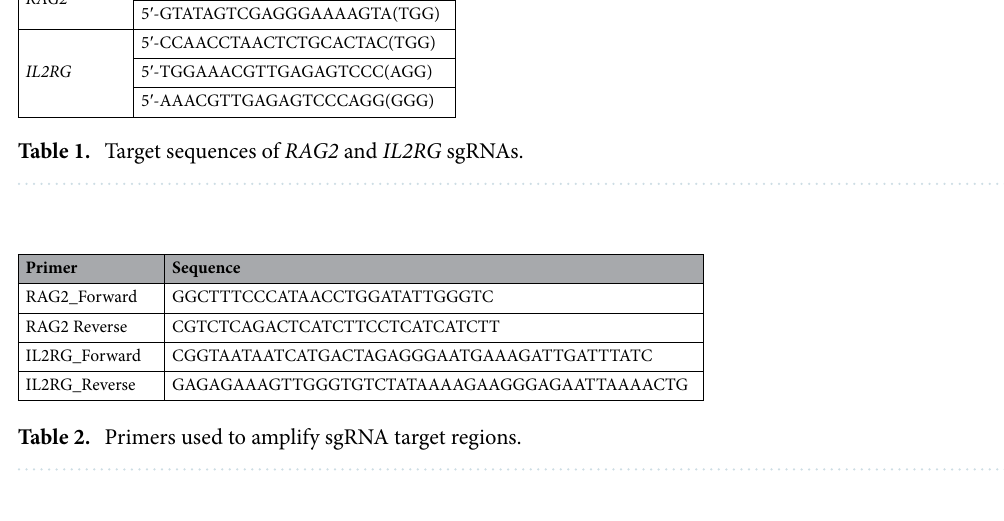
suggests that this model will be highly useful and capable of bridging the gap of translating ablation therapies from the bench to clinical application. Materials and methods Generation of immunodeficient pigs. Oocytes aspirated from sow ovaries were matured in maturation medium (TCM-199 medium supplemented with 0.5 IU ml −1 FSH, 0.5 IU ml −1 LH, 0.82 mM cysteine, 3.02 mM glucose, 0.91 mM sodium pyruvate and 10 ng ml −1 EGF) for 40–44 h. After in vitro maturation, cumulus cells were removed by vortexing in the presence of hyaluronidase, then mature oocytes extruding the first polar body were transferred to fertilization media (modified Tris-buffered medium supplemented with 113.1 mM NaCl,